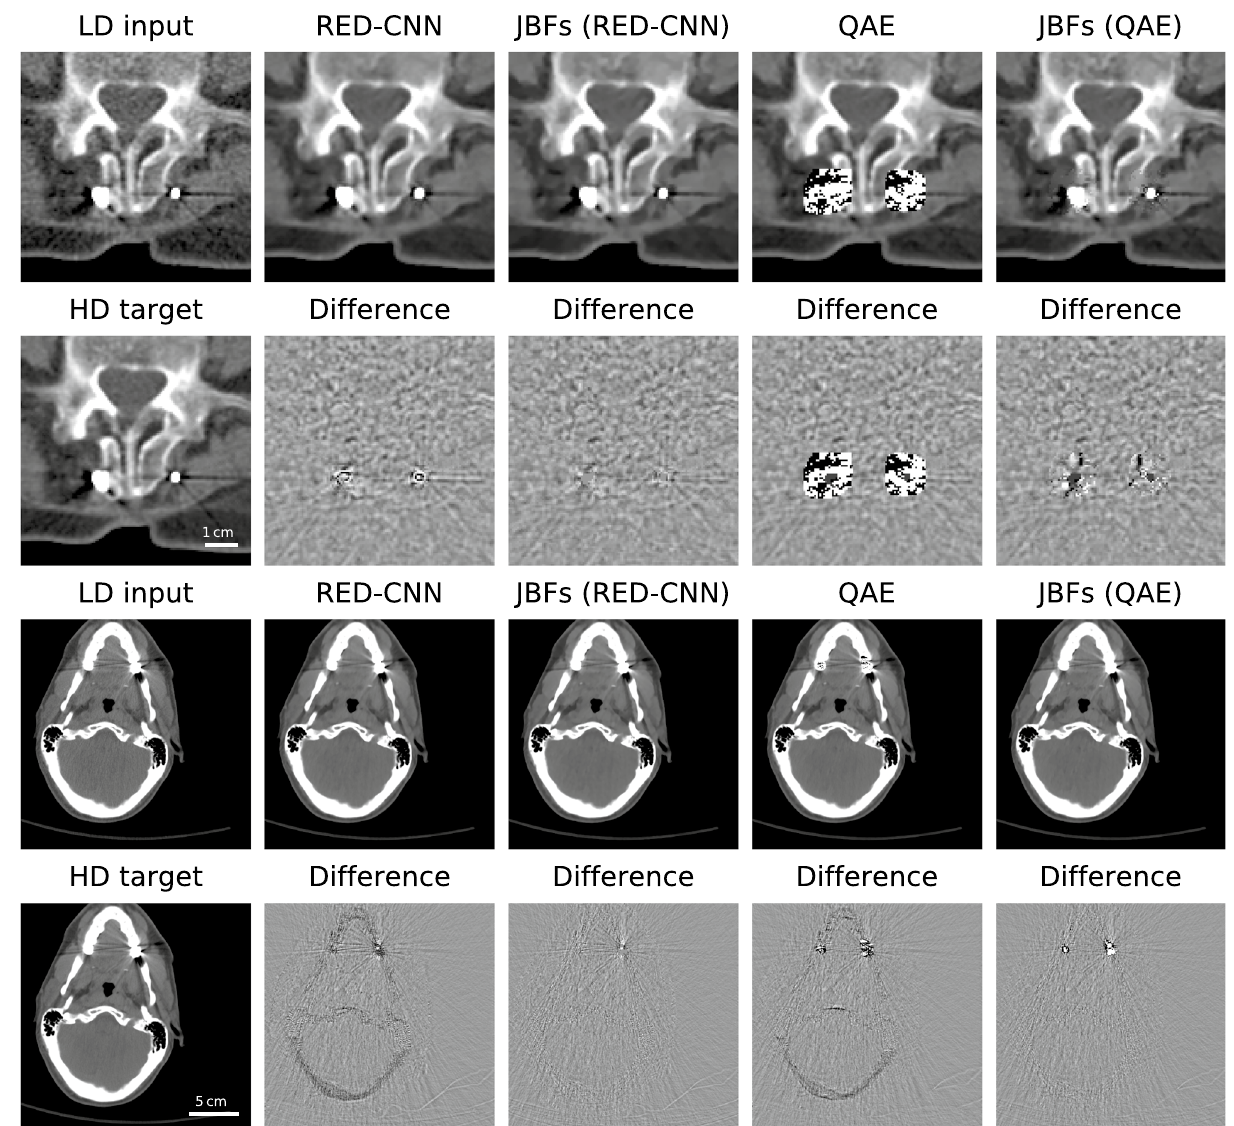
Figure 4. Qualitative denoising results on the ROI highlighted in Fig. 3 and on a head CT slice. Difference images are calculated between model prediction and high-dose (HD) target and are shown in the window [− 50, 50 ] HU for abdomen data and [− 100, 100 ] HU for head data. The reconstruction window is [− 150, 500 ] HU . Our hybrid models visually outperform the respective vanilla deep